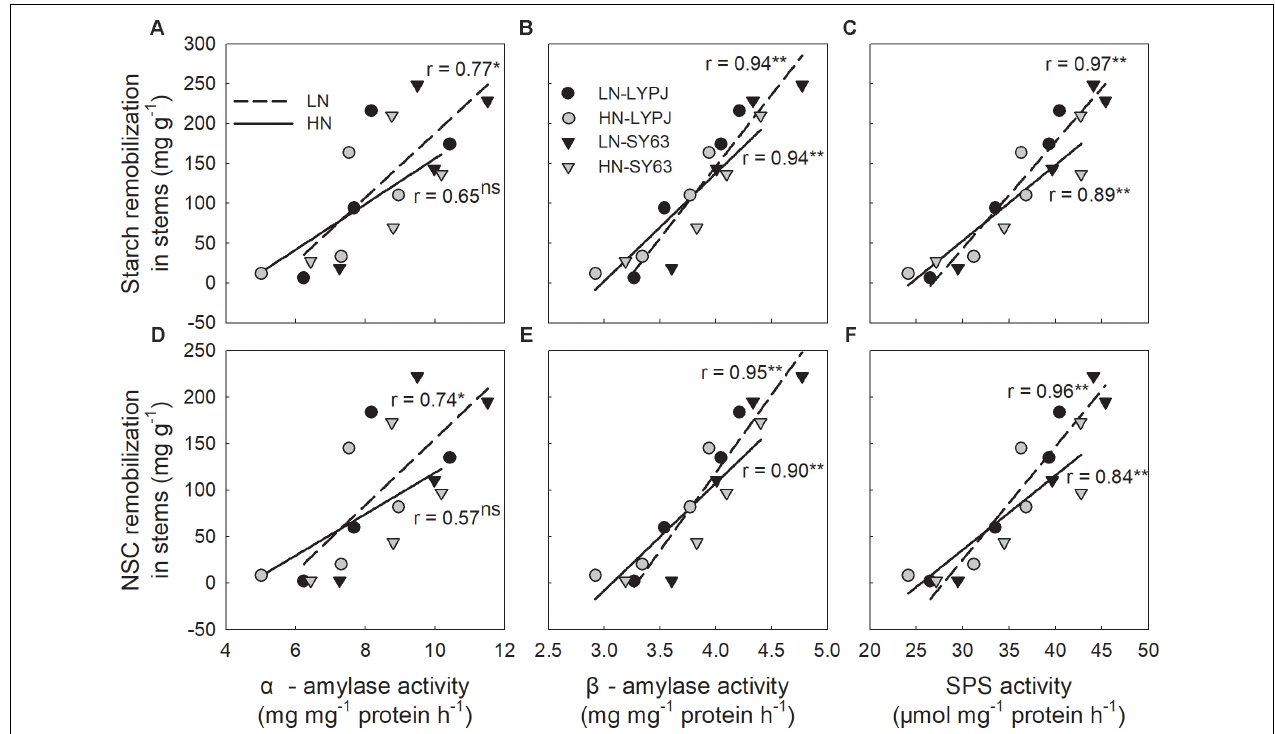
FIGURE 9 | Relationships between stem starch (A,B,C) and NSC (D,E,F) remobilization and the activities of α -amylase, β -amylase, and SPS during the period of rapid starch decrease (6–24 days after heading, n = 4 for each cultivar, n = 8 for each nitrogen treatment). ns, not significant at P < 0.05; ∗ and ∗∗ , significant at P < 0.05 and at P < 0.01,